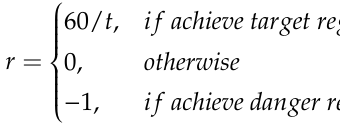
Figure 19. Reward description of the Q-learning algorithm in the training field.